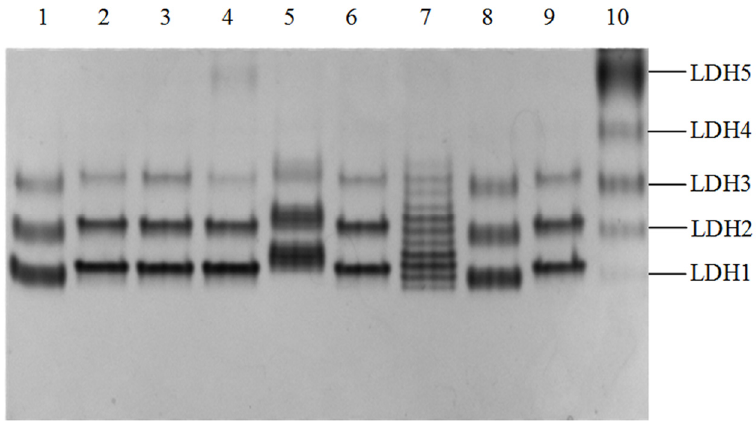
Figure 1. Native PAGE of LDH isozymes in yak heart and skeletal muscles. LDH1-F: lane 1, 8, 10; LDH1-M: lane 2, 3, 4, 6, 9; LDH1-S: lane 5; multiple band phenotype of LDH isozymes: lane 7. Lane 1 to 9: heart tissues, lane 10: longissimus